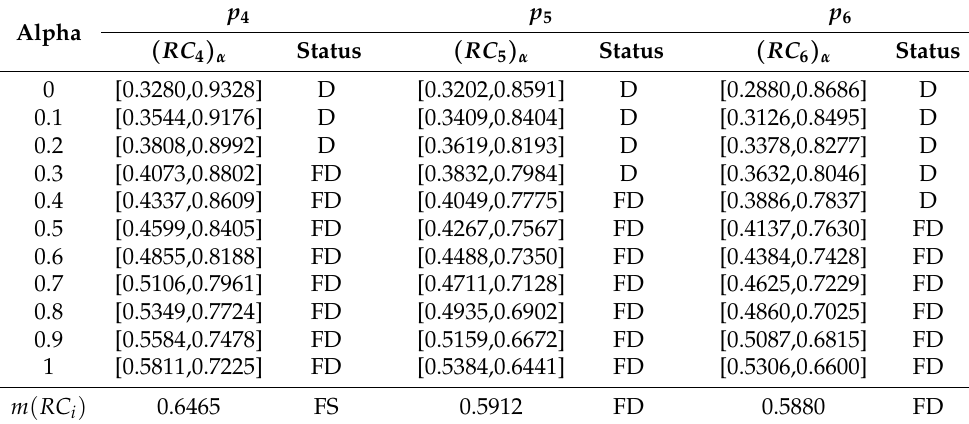
Table 13. The fuzzy relative closeness RC i and related status results continued.